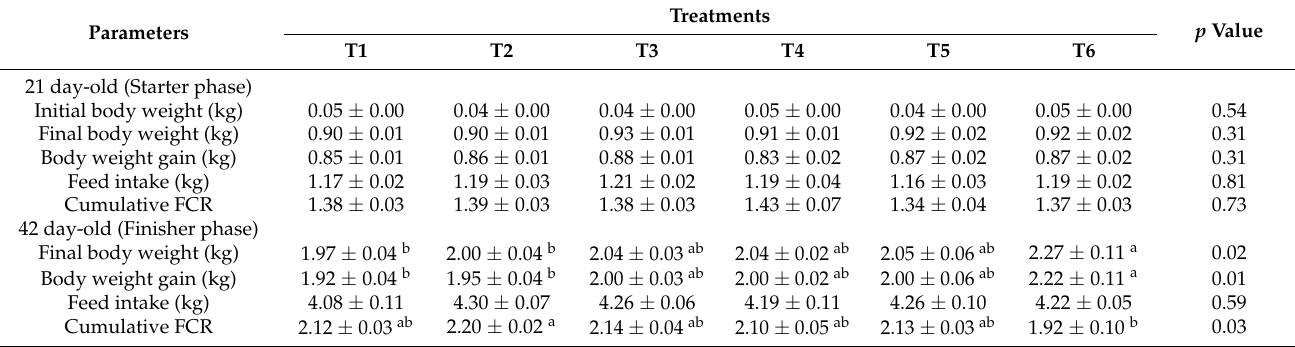
Table 2. Effect of Y. schidigera supplementation on the growth performance of broilers on day 21 and 42. Parameters